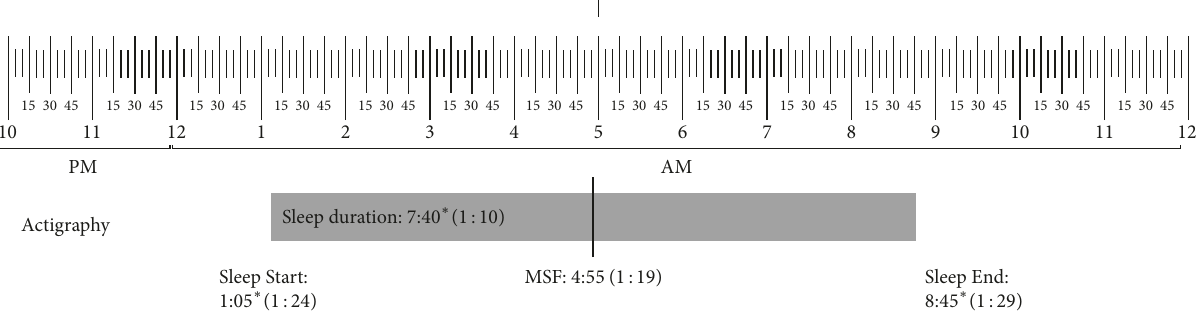
Figure 1: Means and standard deviations of MCTQ and actigraphy on free days. MCTQ: Munich chronotype questionnaire. MSF: midpoint of sleep on free days. SD: standard deviation. Significant differences between the two measures were marked with an asterisk.